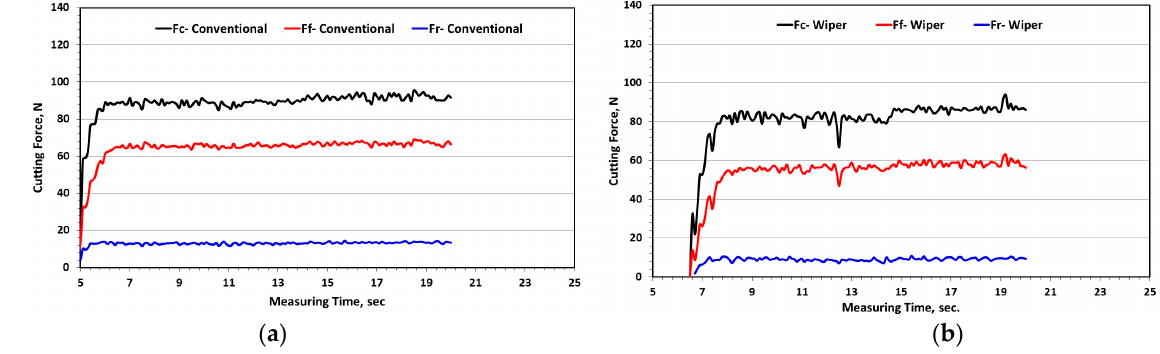
Figure 4. Cutting forces Fr, Ff, and Fc for ( a ) conventional and ( b ) wiper inserts. The material removal rate (MRR) is evaluated using the equation MRR = 1000 V f r d (2) where V represents the surface speed (m/min.), f r is the feed rate (mm/rev.), and d is the depth of cut (mm), and MRR is measured in (mm 3 /min). duced by Guide Co. (Wuhan, China). The camera must be stable and pointed at the target